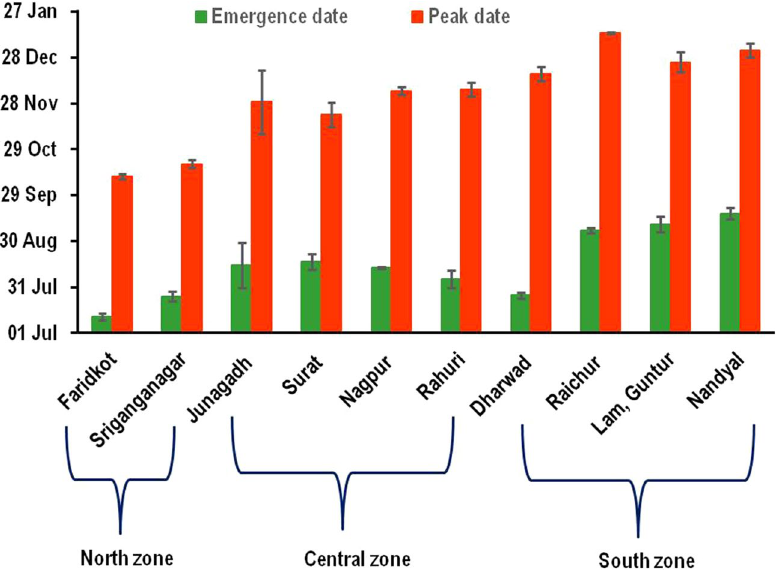
Figure 7. A progressive shift in the dates of beginning of emergence and peak moth catches observed from north to south cotton growing locations of India.